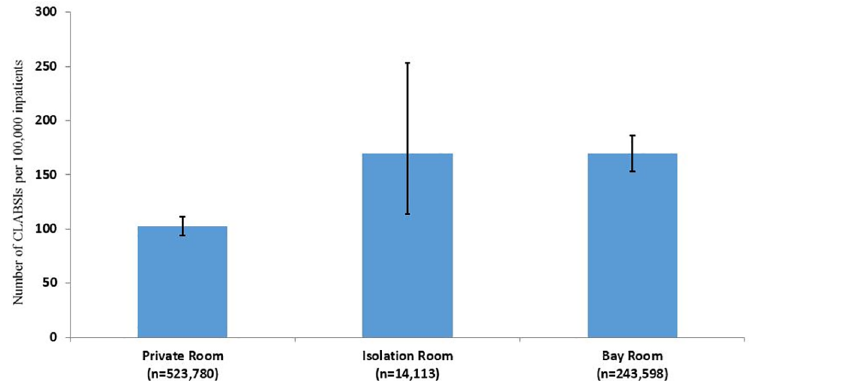
Fig 2. CLABSI Rates based on type of hospital room where patient